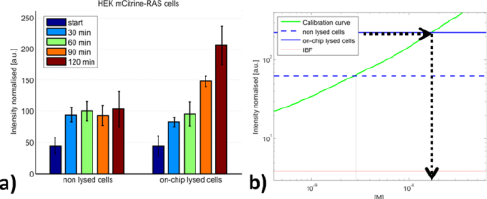
FIGURE 2: a) On-chip Ras-mCitrine protein quantification; b) Calibration curve to extract concentration of cellular